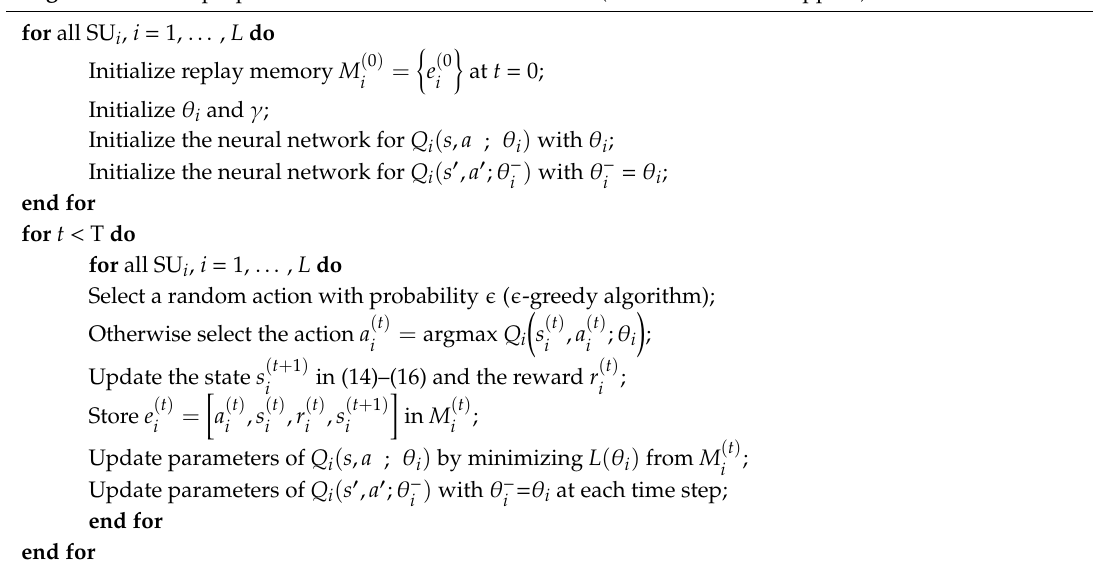
Algorithm 1. The proposed TL-PDSH scheme without TL (when no new SUs appear). for all SU i , i = 1, ... , L